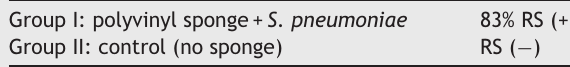
Incidence of rhinosinusitis in the groups of the study by Marks (1997).